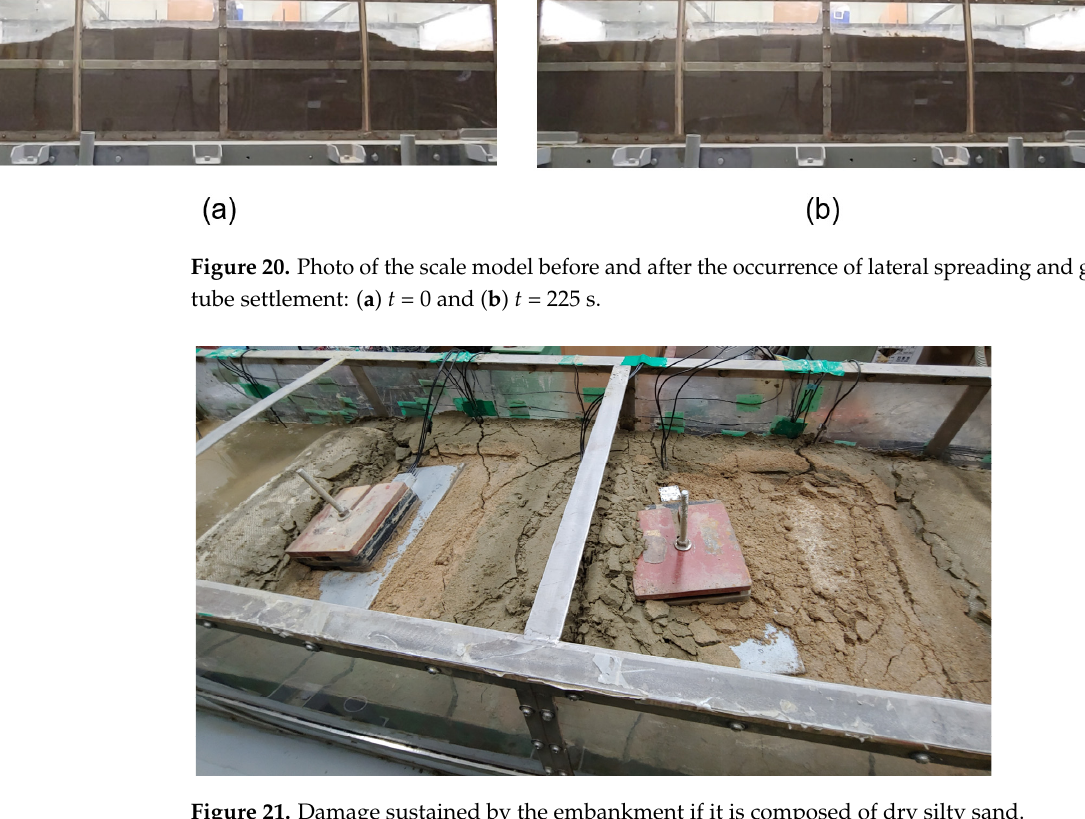
Figure 21. Damage sustained by the embankment if it is composed of dry silty sand.